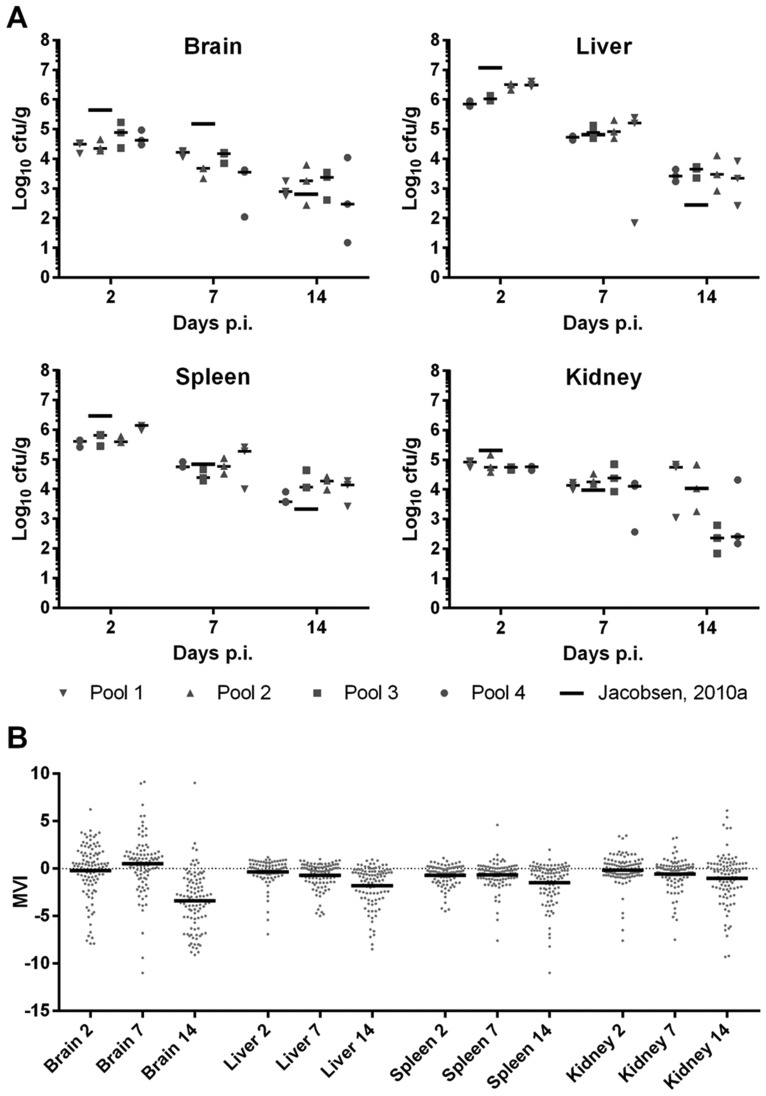
Fungal burdens in different organs. (A) Absolute fungal burden and decrease during the infection experiment were comparable among the four pools, and to the data obtained from a single-strain infection experiment using the same model (Jacobsen et al., 2010a). Black bars show the median values. (B) Enrichment or depletion of mutants in the organs. Dots represent MVIs of all individual mutants retrieved from mice. Negative MVIs indicate depletion of the fungal load of a mutant relative to the wild type. Black bars indicate mean MVI. The mutants are generally less fit in the mouse organs than the wild type, and their depletion generally increases continuously over time (with the exception of the brain).